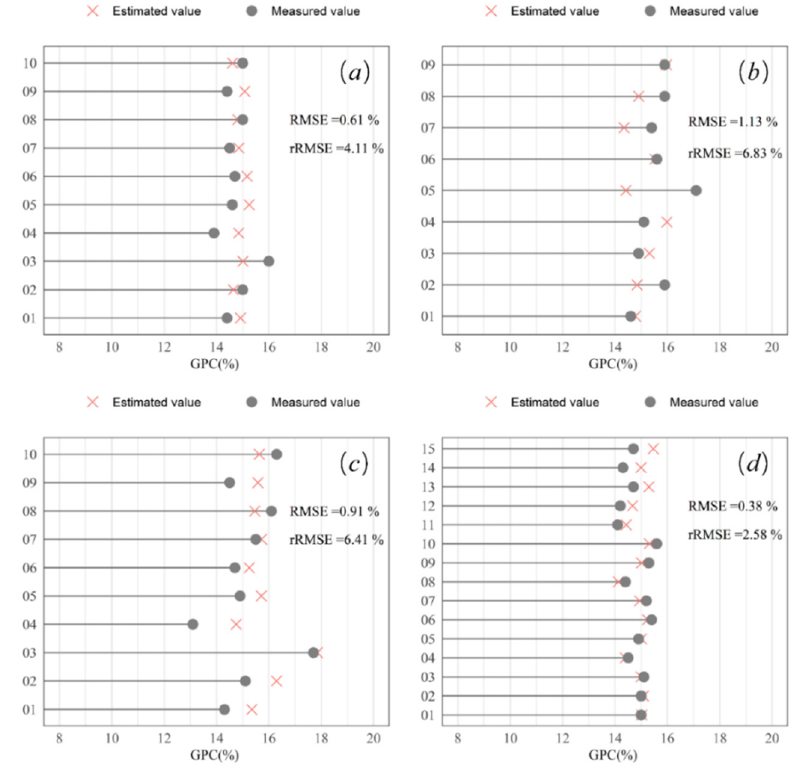
Figure 9. Spatial verification point diagram of GPC in Beijing, Xiaotangshan, and Renqiu City: ( a ) Renqiu in 2018; ( b ) Beijing in 2018; ( c ) Xiaotangshan in 2018; ( d ) Xiaotangshan in 2019.